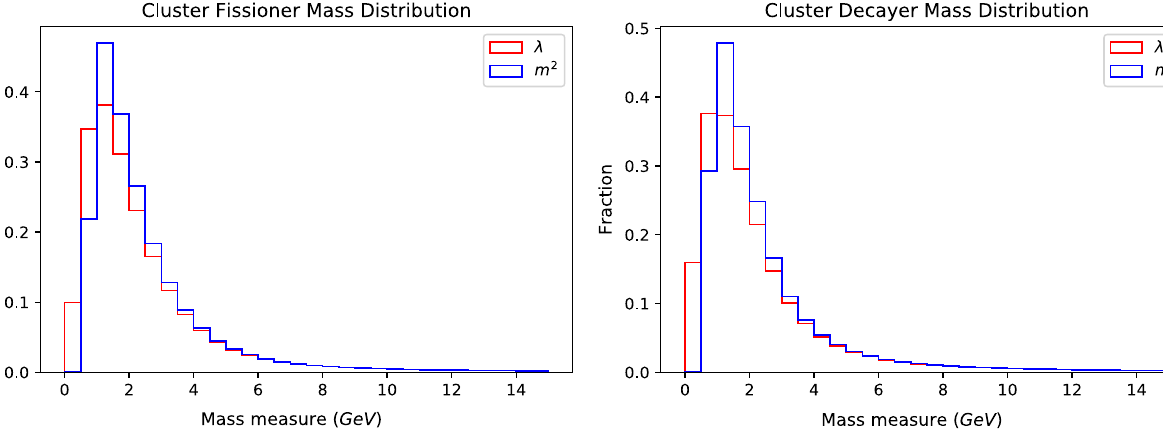
Table 4 Results for the tuned characteristic mass scales m 0 , in units of GeV, of our new model using our λ measure (defined in Eq. 5) of a colour-singlet object for LEP and LHC